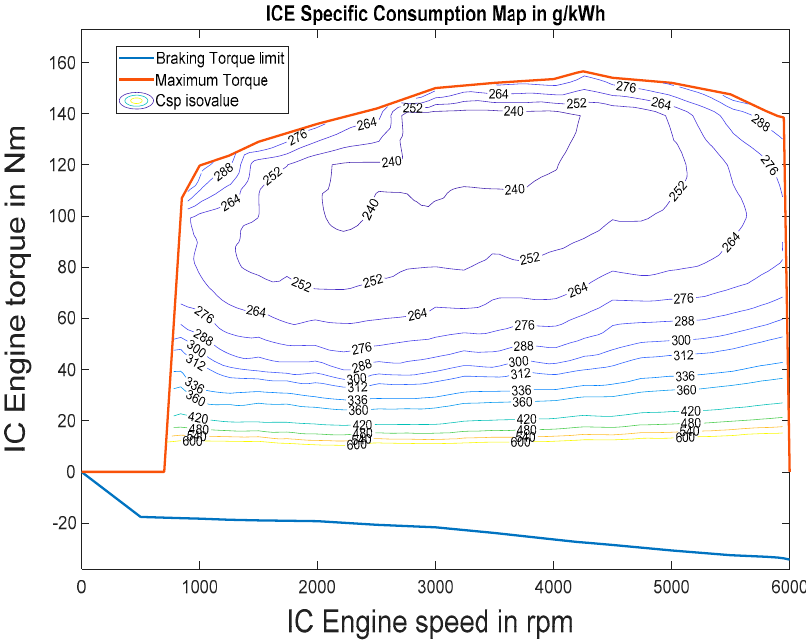
Figure 7. ICE cartography presenting fuel flow within engine torque and speed limits.